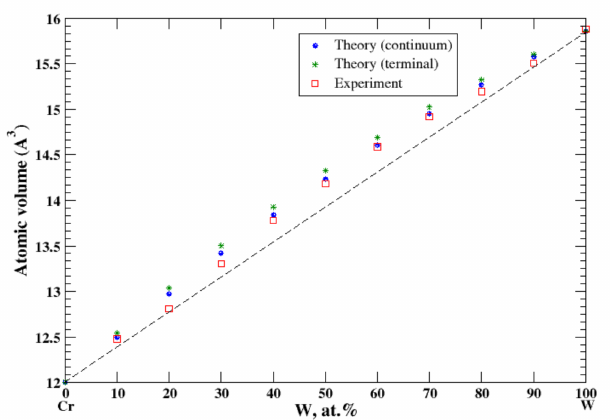
Figure 22. Atomic volume vs. concentration for Cr-W alloy system. The experimental data are from Ref. [16] (p. 545 and p.